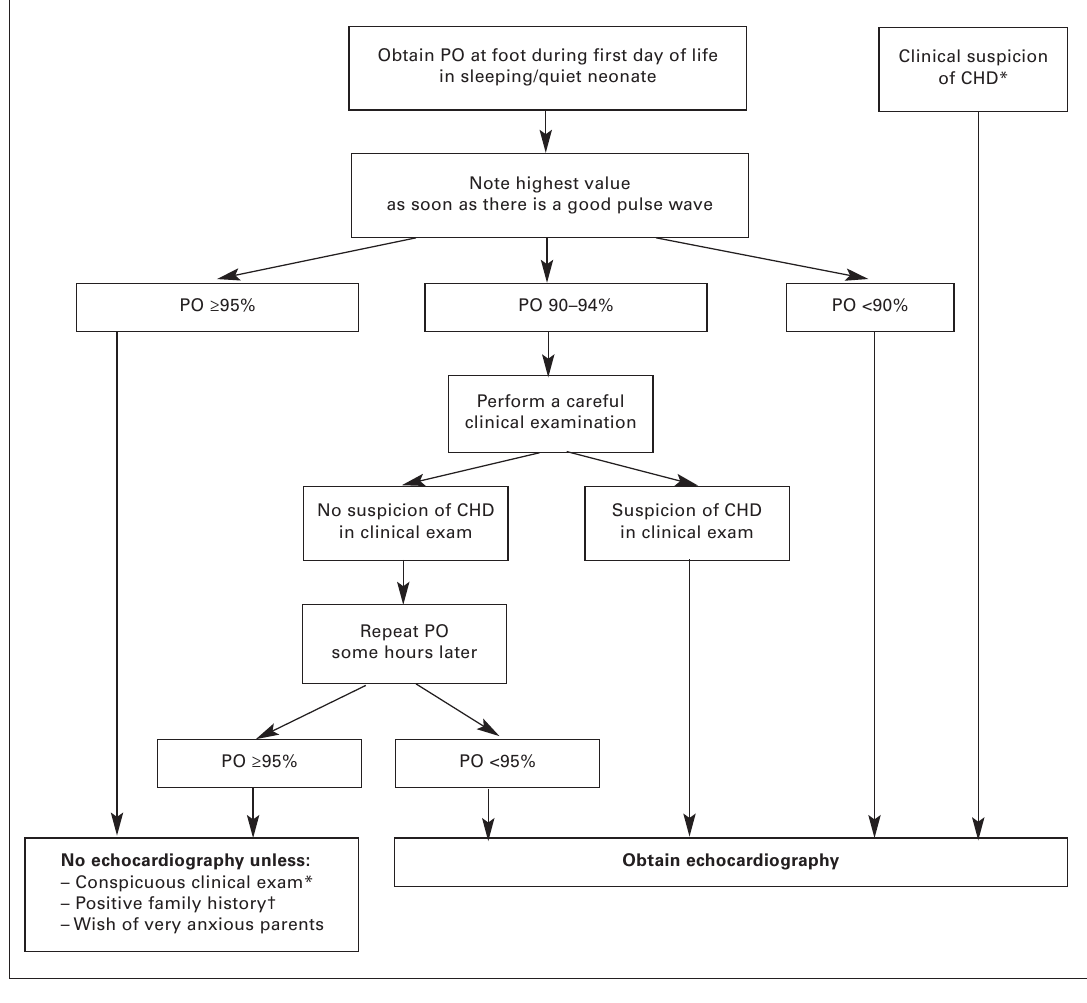
Flowchart of the